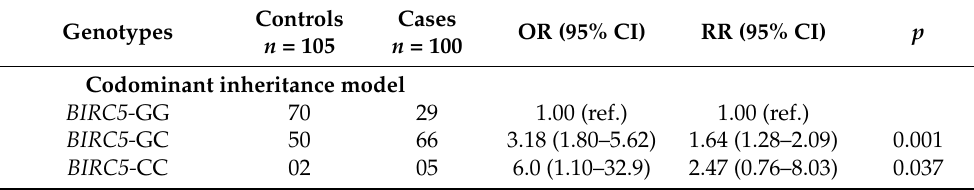
Table 7. Association of BIRC5-rs 9904341 G > C gene variation in cases and